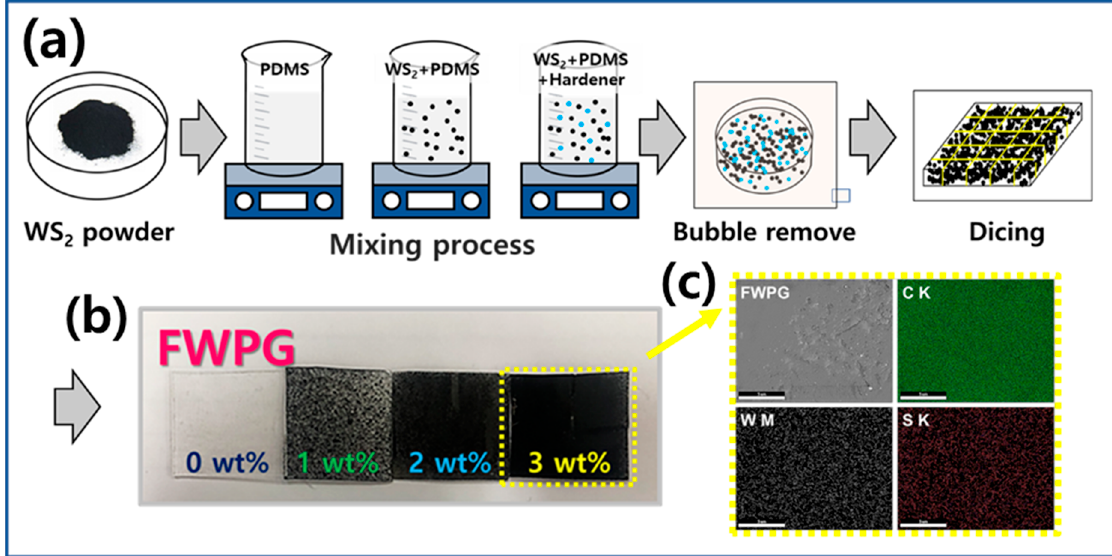
Figure 2. ( a ) Illustration fabrication process of a WS 2 flexible sensor. ( b ) Actual photo of the flexible WS 2 piezoelectric generator (FWPG) with various proportions of WS 2 (0, 1, 2, and 3 wt%). ( c ) EDS mapping of the 3 wt% WS 2 flexible sensor (C, W, and S).